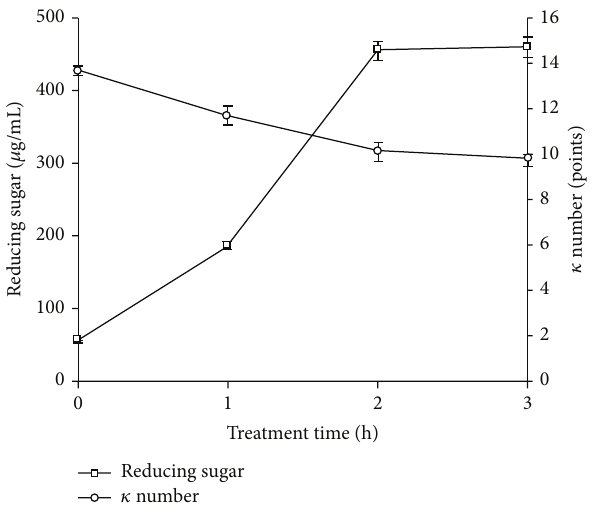
Figure 9: Effect of crude xylanase preparation treatment on level of the reducing sugars released and kappa number of kraft